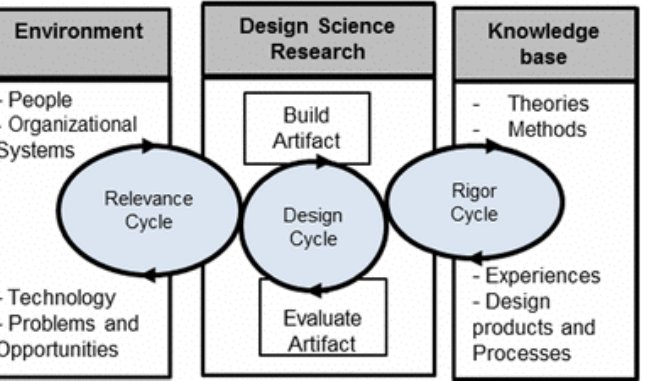
Figure 1. Information System Research (ISR) framework for design of mHealth technology adopted from [17].